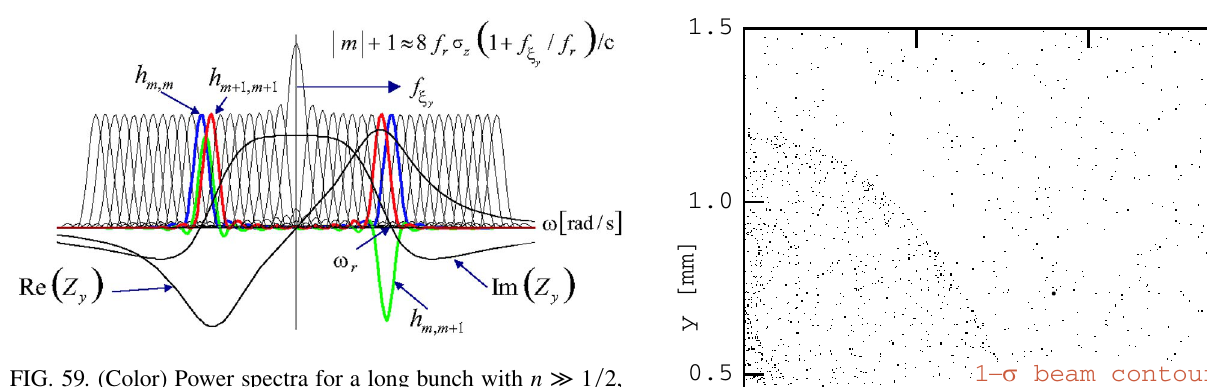
FIG. 59. (Color) Power spectra for a long bunch with n (cid:13) 1 = 2 , as well as the real and imaginary parts of the driving broadband impedance [84].